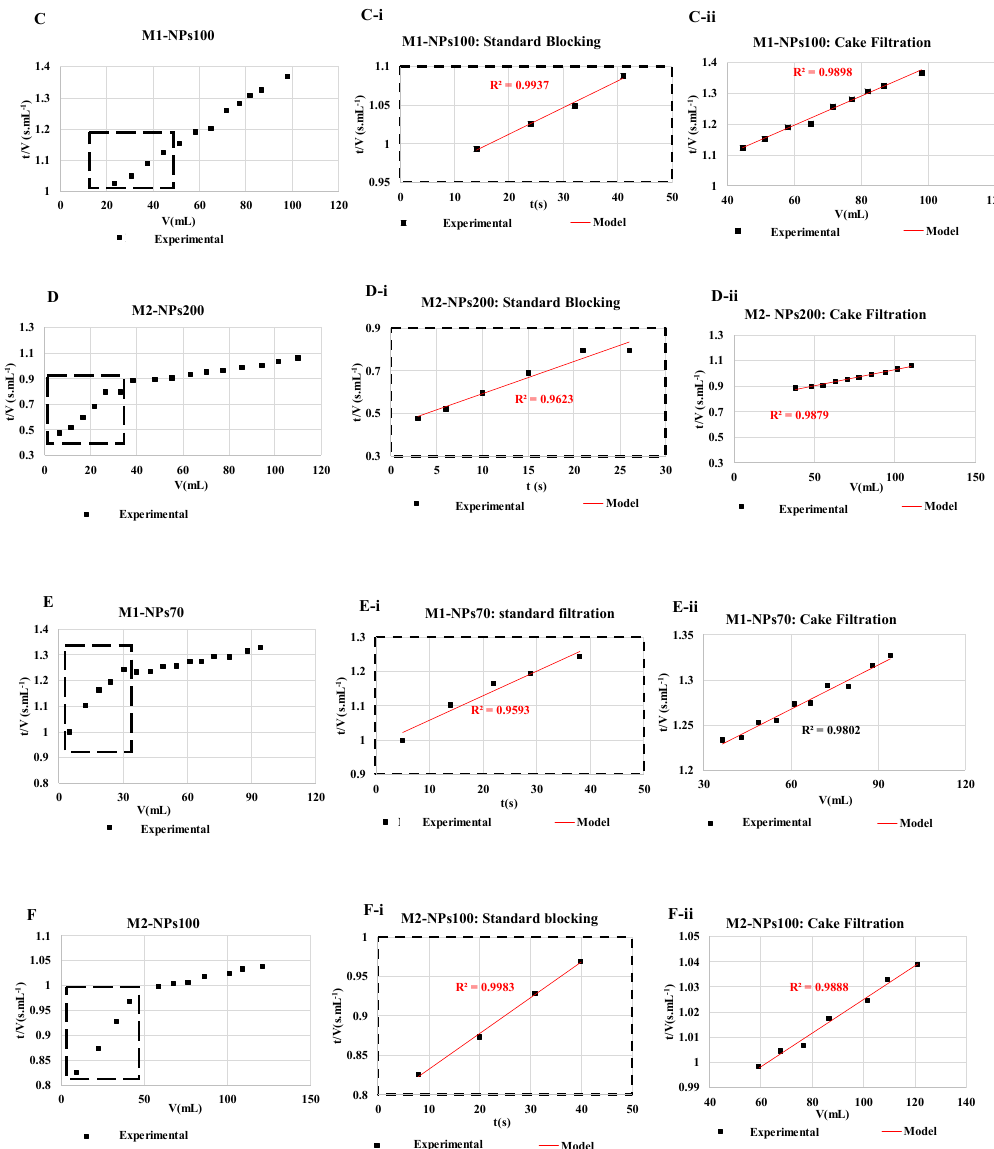
Figure 9. Fouling models found for NPs filtrations of ( A ) NPs 200 with membrane M1, ( B ) NPs 300 nm with membrane M2, ( C ) NPs 100 with membrane M1, ( D ) NPs 200 nm with membrane M2, ( E ) NPs 70 with membrane M1, and ( F ) NPs100 with membrane M2. The experiments are performed at same experimental conditions [TMP ~ 0.5 bar, room temperature].